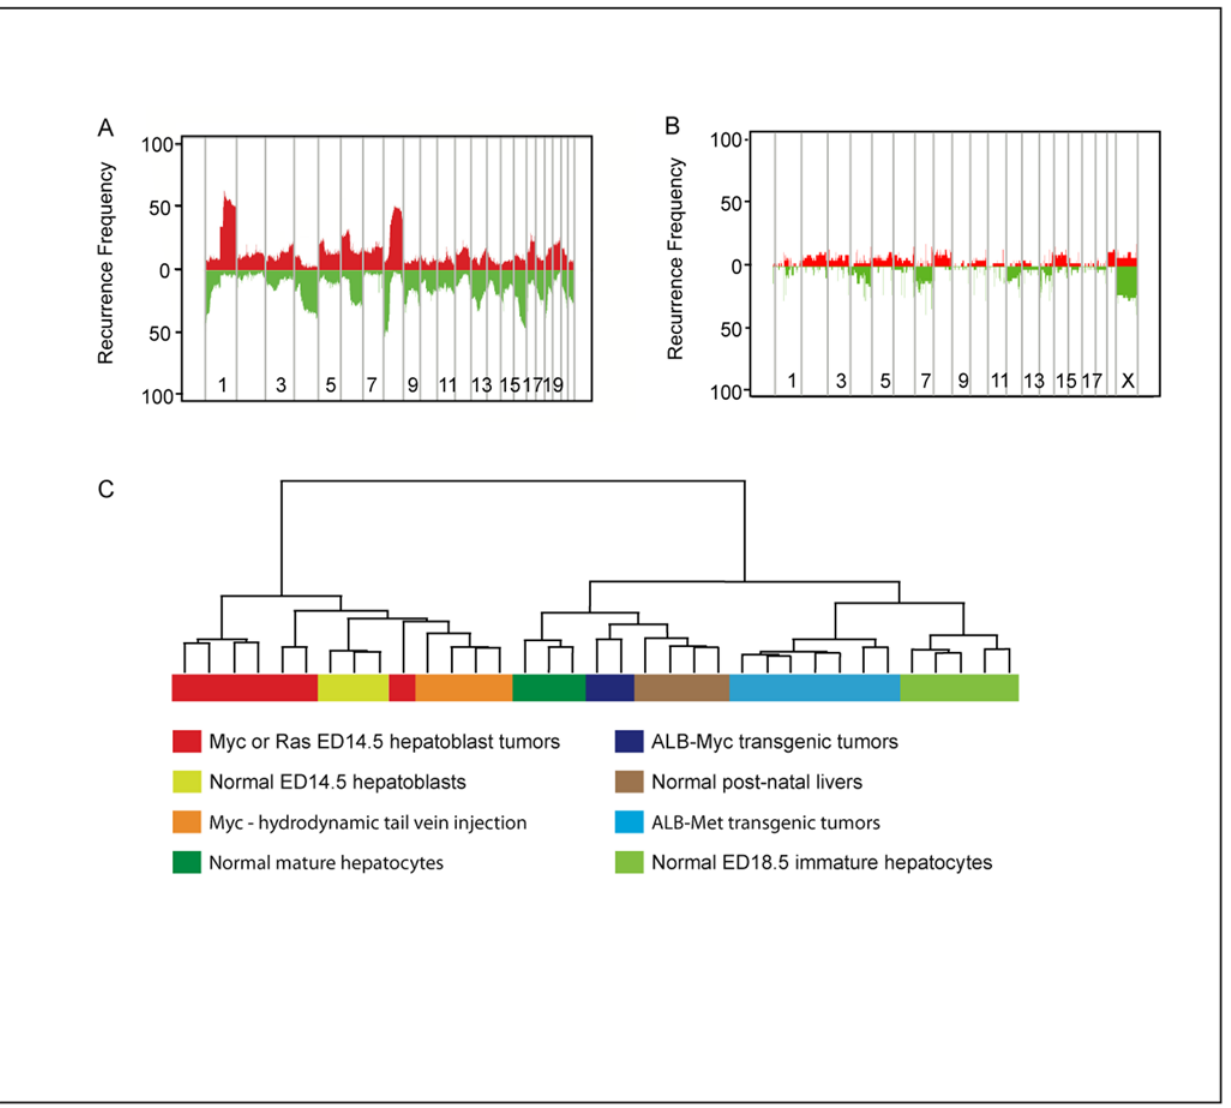
Fig 1. Comparative genomic analysis of human and mouse model HCC. (A) Frequency plots of copy number alterations in human HCC. Frequency of gains (red) and losses (green) as determined by ROMA array CGH analysis of 101 human HCC samples. (B) Frequency plots of copy number alterations in mouse model HCC as determined by ROMA array CGH analysis in 38 mouse model HCC samples. (C) Unsupervised hierarchical clustering of expression profiles of various mouse HCC tumors and normal stages of liver development. See S3 Table for a description of the different